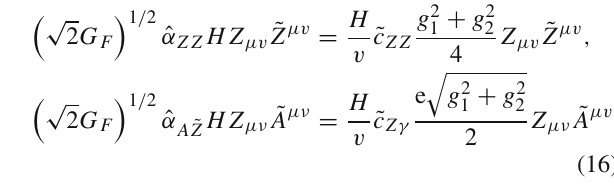
and ˆ α from various A ˜ Z Z ˜ Z